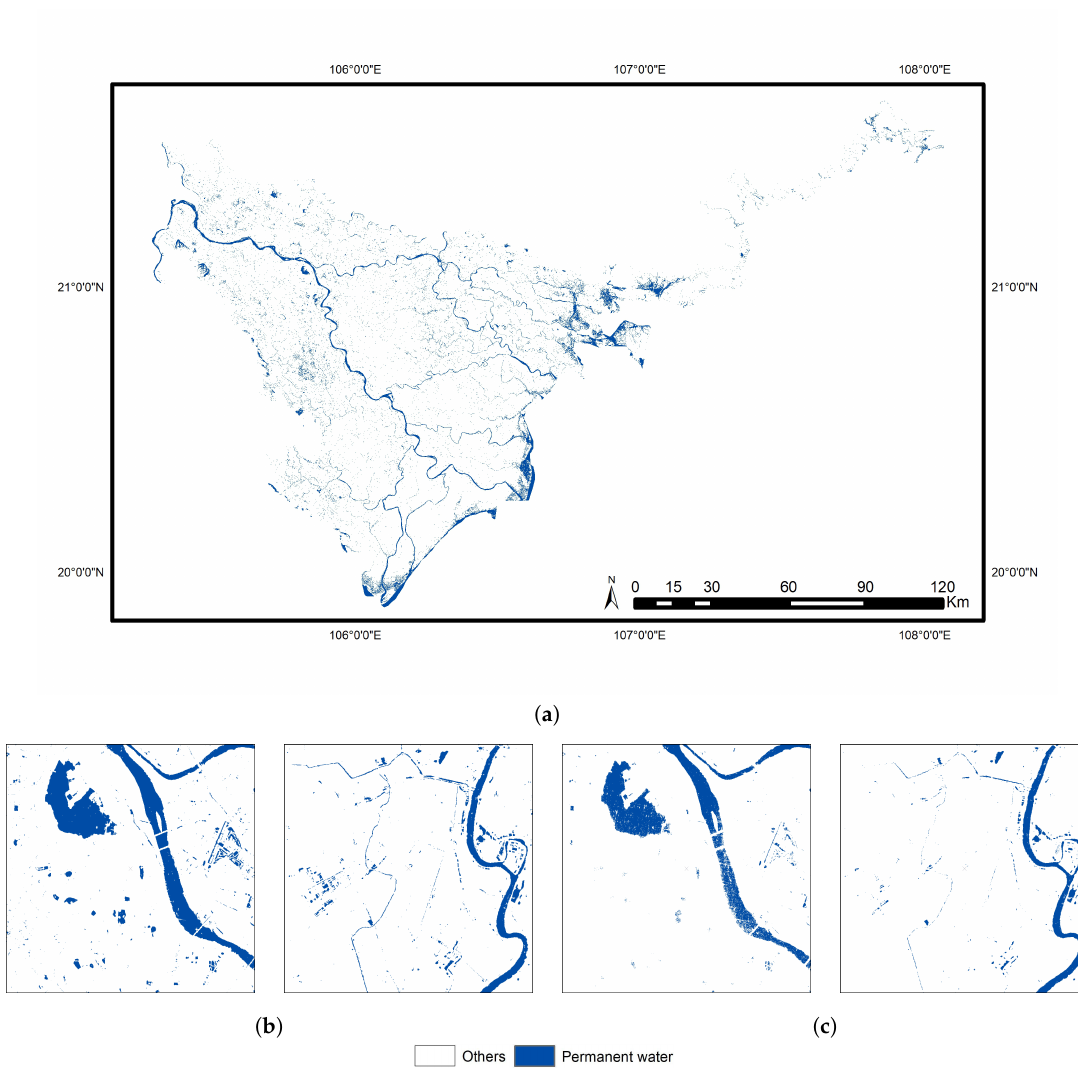
Figure 8. The permanent water map estimated from VV data for the RRD in 2018 ( a ) and Specified scenes of permanent water derived from VV data ( b ) and VH data ( c